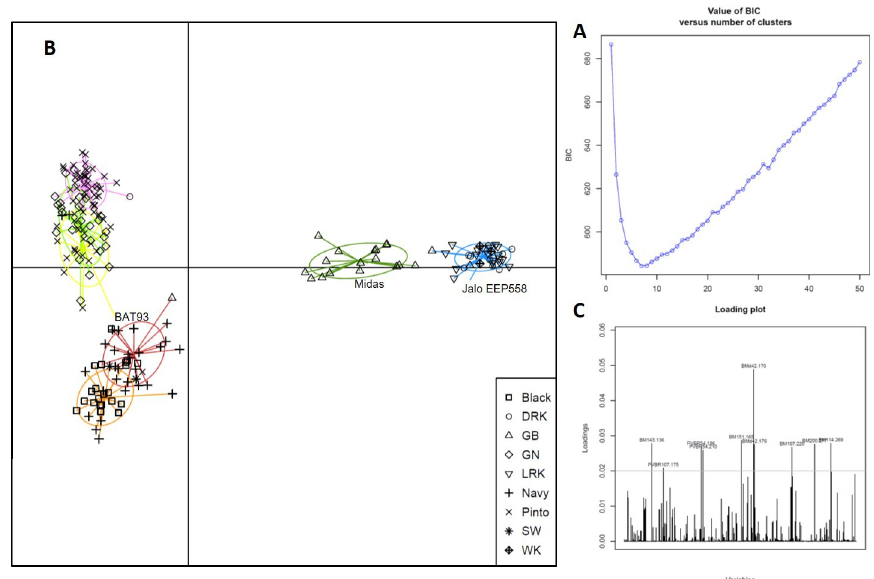
Fig 4. Results of DAPC applied to the 192 commercial advanced cultivars of common bean. A. Bayesian Information Criteria (BIC) for increasing values of the number of clusters. The chosen number of clusters was K = 7. B. Scatterplot of the first two principal components of the DAPC on the common bean collection. Individuals are represented by symbols according to their market class. Colours and inertia ellipses identify the clusters. C. Loading plot generated from using all 58 SSR, with the horizontal line representing an arbitrary threshold value of .002. Illustrates which SSR contributed most to the individual principle component analysis. https://doi.org/10.1371/journal.pone.0211342.g004 clustering methods was the propensity of the DAPC analysis to assign individuals to a single cluster compared to STRUCTURE, which was able to assign admixed individuals to multiple clusters. One interesting feature of the DAPC method is that it allows calculating the